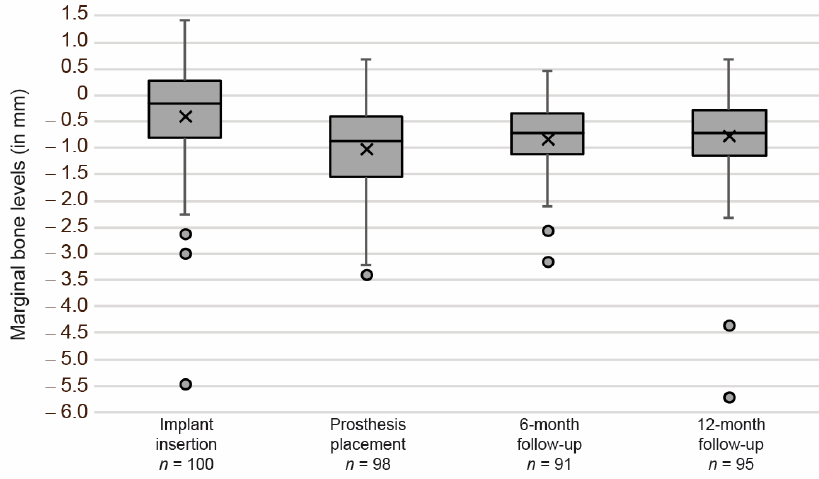
Figure 3. Evolution of marginal bone levels from implant insertion to the final follow-up, 12 months after prosthetic delivery. Box and whisker plot; circles indicate outliers and crosses the mean